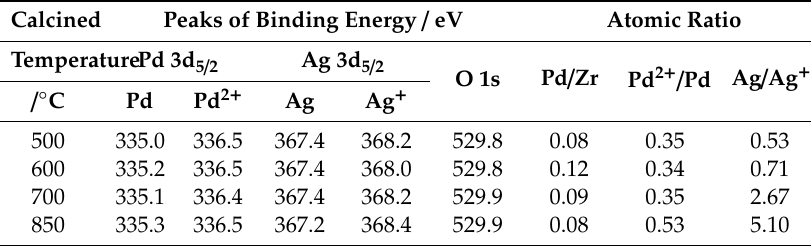
Table 1. Chemical state analysis from XPS